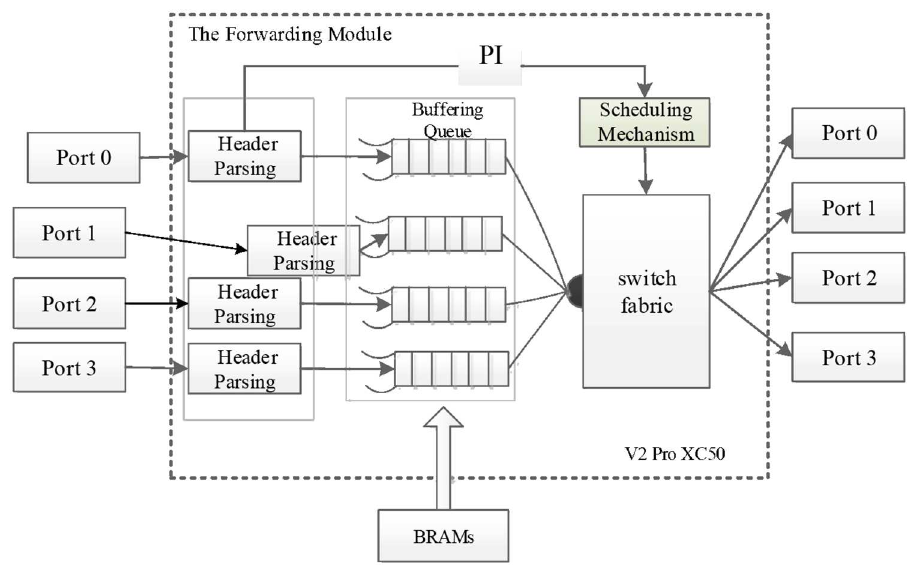
Fig 7. The structure of the VS based on NetFPGA. The packets are placed in buffing queuesrangingfrom 0 to 3 basedon off-chip BRAM without the use of off-chip SRAMs and DRAMs.